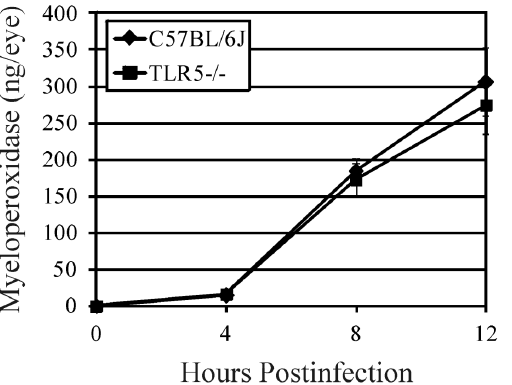
Figure 4. Influence of TLR5 on infiltration of PMN into mouse eyes during experimental B.cereus endophthalmitis. C57BL/6J and TLR5 2 / 2 mouse eyes were injected with 100 CFU B. cereus . PMN infiltration was estimated by quantifying MPO in whole eyes by sandwich ELISA. MPO levels were similar in these groups at all times points postinfection (P $ 0.17), suggesting that the absence of TLR5 did not alter the PMN response during infection. Values represent the mean 6 SD for N $ 4 per group for at least 2 separate experiments. *P #